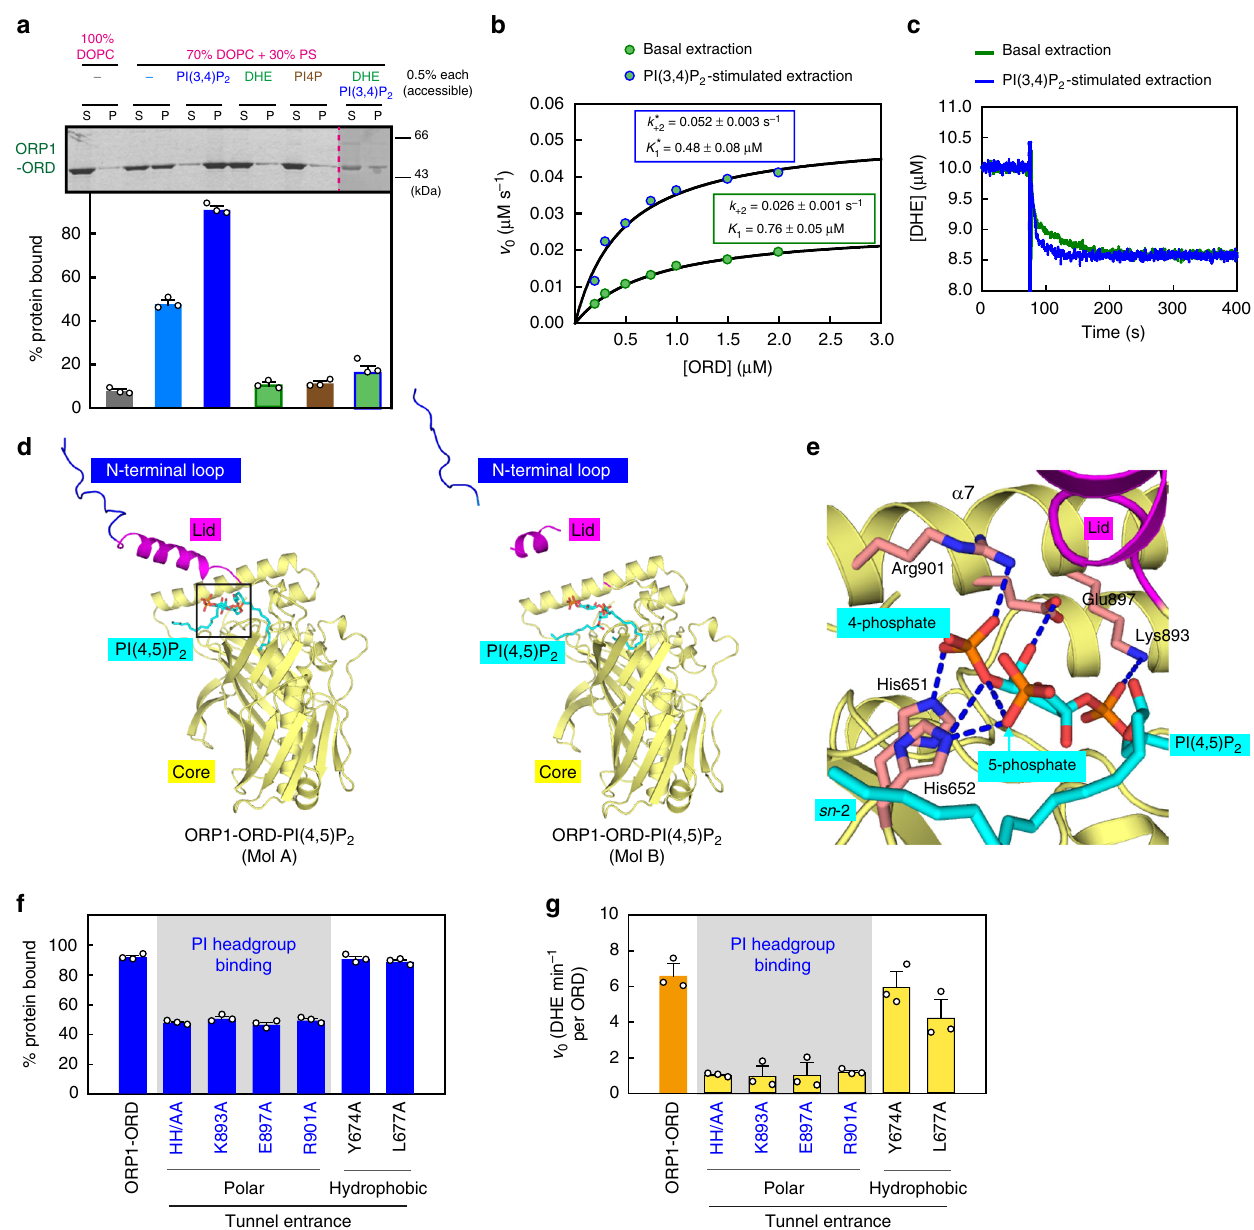
Fig. 8 PI(3,4)P 2 /PI(4,5)P 2 headgroup facilitates speci fi c membrane targeting. a Membrane association analyses with liposomes supplemented with indicated lipids. The ratio of ORP-ORD and indicated lipid is 1:5. The last two lanes are from a separate experiment. b Kinetic analyses of DHE extraction in the absence or presence of PI(3,4)P 2 (mean ± s.e.m., n = 3). c Representative time traces of DHE extraction by ORP1-ORD (1.5 μ M). d Structure of ORP1- ORD in complex with PI(4,5)P 2 . The PI(4,5)P 2 ligand is highlighted as cyan stick. e Close-up view of PI(4,5)P 2 headgroup binding at the tunnel entrance of ORP1-ORD (Mol A). f , g Effects of tunnel entrance mutations on the bound fraction of ORP1-ORD with PI(3,4)P 2 -containing liposomes ( f ) and the initial rates of PI(3,4)P 2 -dependent DHE transport with both lipids embedded in the donor liposomes ( g ). (For all bar graphs, data are shown as mean ± s.e.m. (error bar), n =